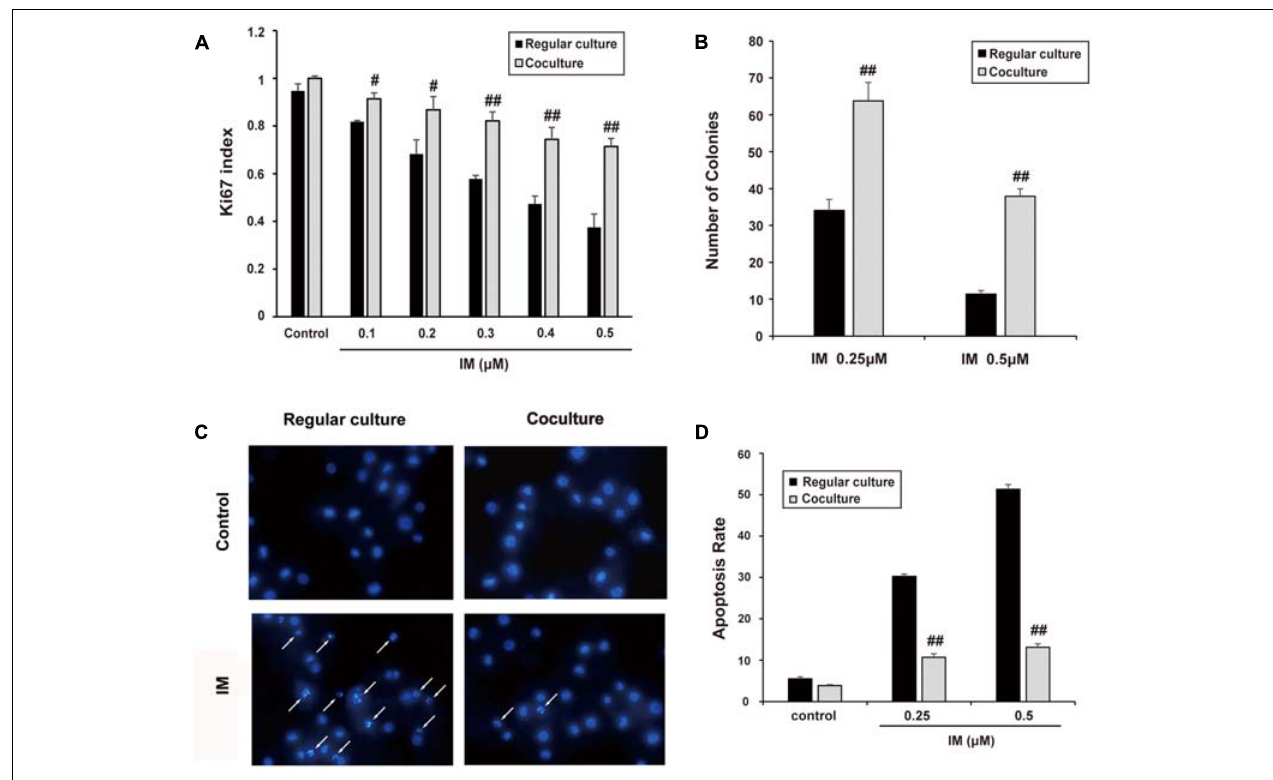
FIGURE 1 | Cell co-culture rendered K562 cells resistant to IM. K562 cells were cultured alone or co-cultured with HS-5 cells for 12 h and then treated IM as indicated for 36 h. Cells were subjected to Ki67 cell proliferation detection, Soft agar assay, DAPI and Annexin V/PI staining assay as described in Section “Materials and Methods.” (A) Cell growth indexes were calculated by counting Ki67 positive staining of K562 cells. (B) Soft agar colony assay was performed and all formed colonies of regular cultured and co-cultured cells in each well were quantified when treated with indicated concentration of IM. Results represent mean values of three independent experiments ± SD. (C) Representative photos of DAPI staining were present and nuclear condensation was labeled as white arrows. (D) Regular cultured and co-cultured cells treated with indicated concentration of IM were subjected to Annexin V/PI double-staining and then analyzed by flow cytometry. The apoptotic rate of cells was represented as mean ± SD for three independent experiments. ( # p < 0.05 and ## p < 0.01 compared with regular culture).